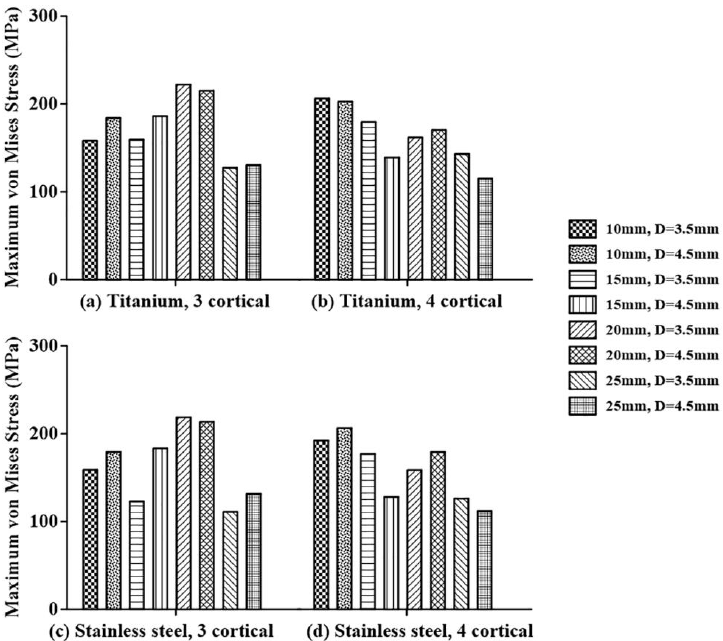
Figure 10. Analysis of the maximum von Mises stresses of the adjacent bone in terms of the diameter of the screw for: ( a ) titanium screw penetrating three cortical bones, ( b ) titanium screw penetrating four cortical bones, ( c ) stainless steel screw penetrating three cortical bones, and ( d ) stainless steel screw penetrating four cortical bones.